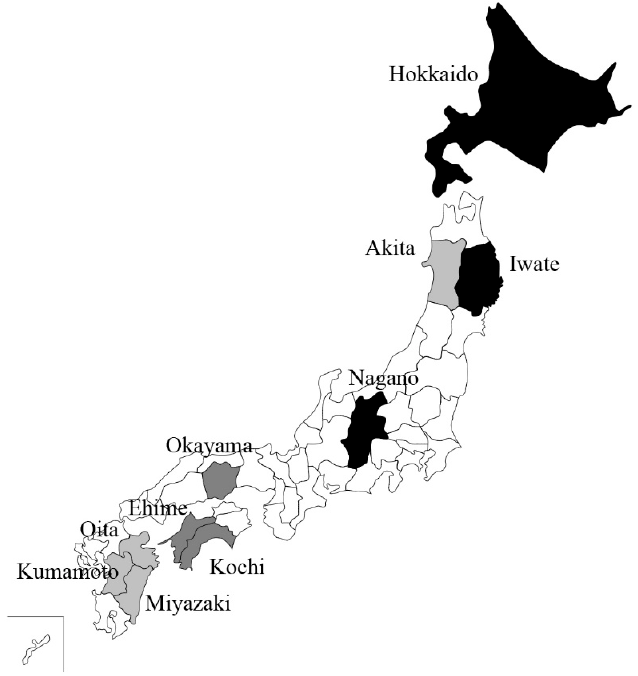
Figure 1. Top production regions of sugi, hinoki, and karamatsu logs. The darkest color shows the production regions for karamatsu ; the brightest color for production regions of sugi ; while others for hinoki .